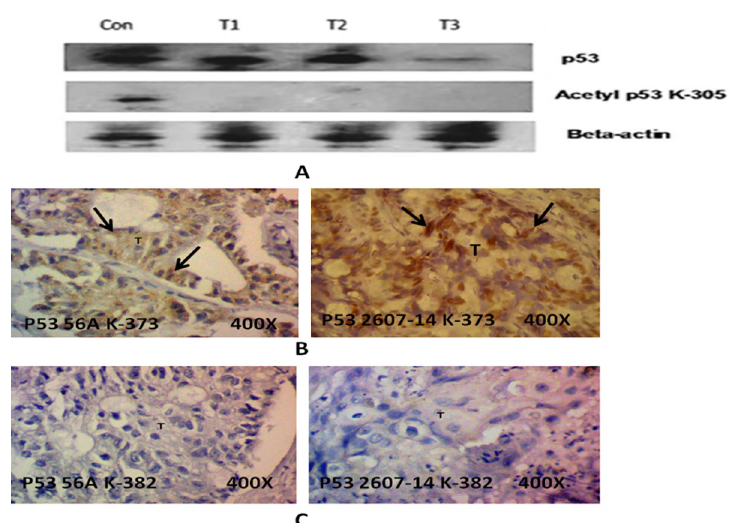
Fig 6. (A) Representative western blot showing the absence of p53 acetylation in HPV positive cervical cancer cases compare to non-neoplastic control at site K305. (B) Representative panel of IHC showing the presence of p53 acetylation in HPV positive cervical cancer at site K373. The positive results were observed in very few cases. (C) Representative panel of IHC showing the absence of p53 acetylation in HPV positive cervical cancer at site